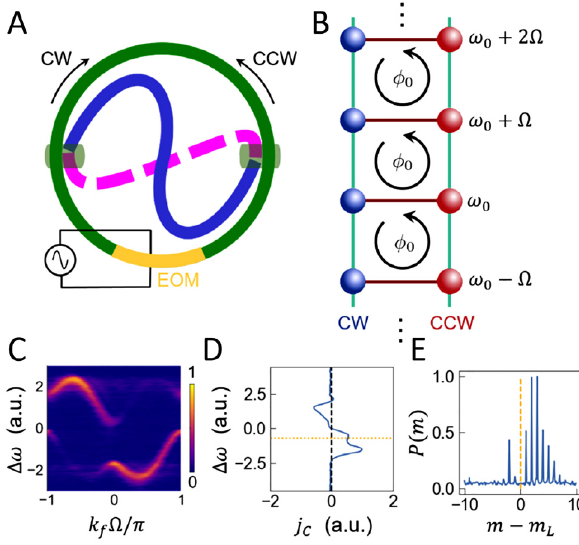
Figure 6: Topology in synthetic space, adapted from the study by Dutt et al. [128]. (A) Schematic of a single ring formed by a fi bre loop under the dynamic modulation. The CW and CCW modes form a spin degree of freedom and are coupled via connecting waveguides of differinglengths.(B)ThecorrespondinglatticegivesasyntheticHall ladder threaded by an effective magnetic fl ux ϕ 0 with two independent synthetic dimensions. (C) Measuring the transmission of an input CW excitation as a function of the detuning Δ ω reveals two bands with opposite chirality. (D) The chiral current j C , a measure of the spin-sensitive direction of frequency conversion, is opposite for the two bands. (E) Steady-state normalized photon number P ( m ) of the CW mode at the m th resonance, where m L is the resonant mode closet to the input laser, indicating preferential conversion to higher